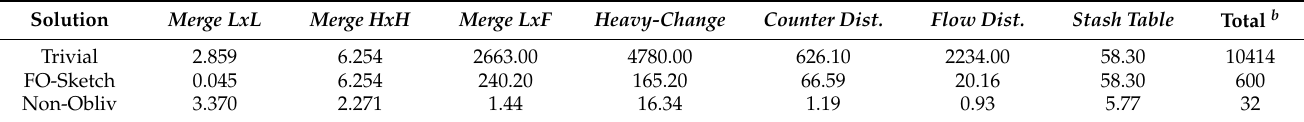
Table 3. Time consumption a (ms) for critical functions with the recommended setting.